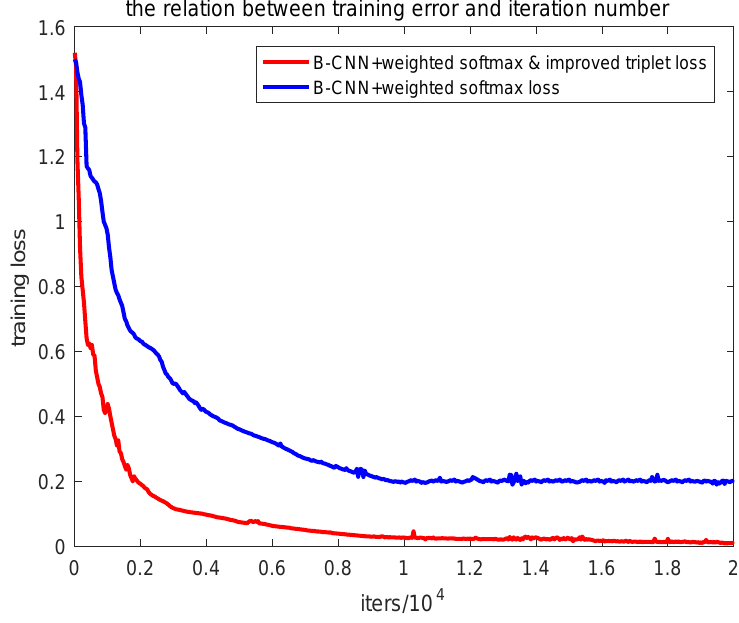
Figure 7. Relation between training error and iteration number.